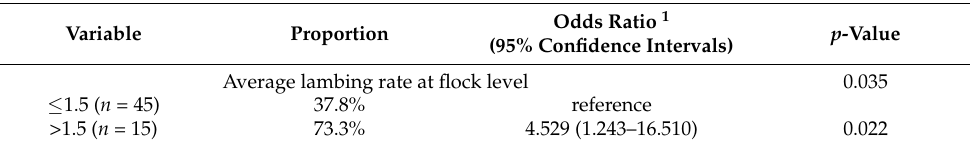
Table 4. Results of multivariate analysis for associations with occurrence 1 of peri-parturient deaths in at least one year of a two-year study in 60 sheep flock in Greece.